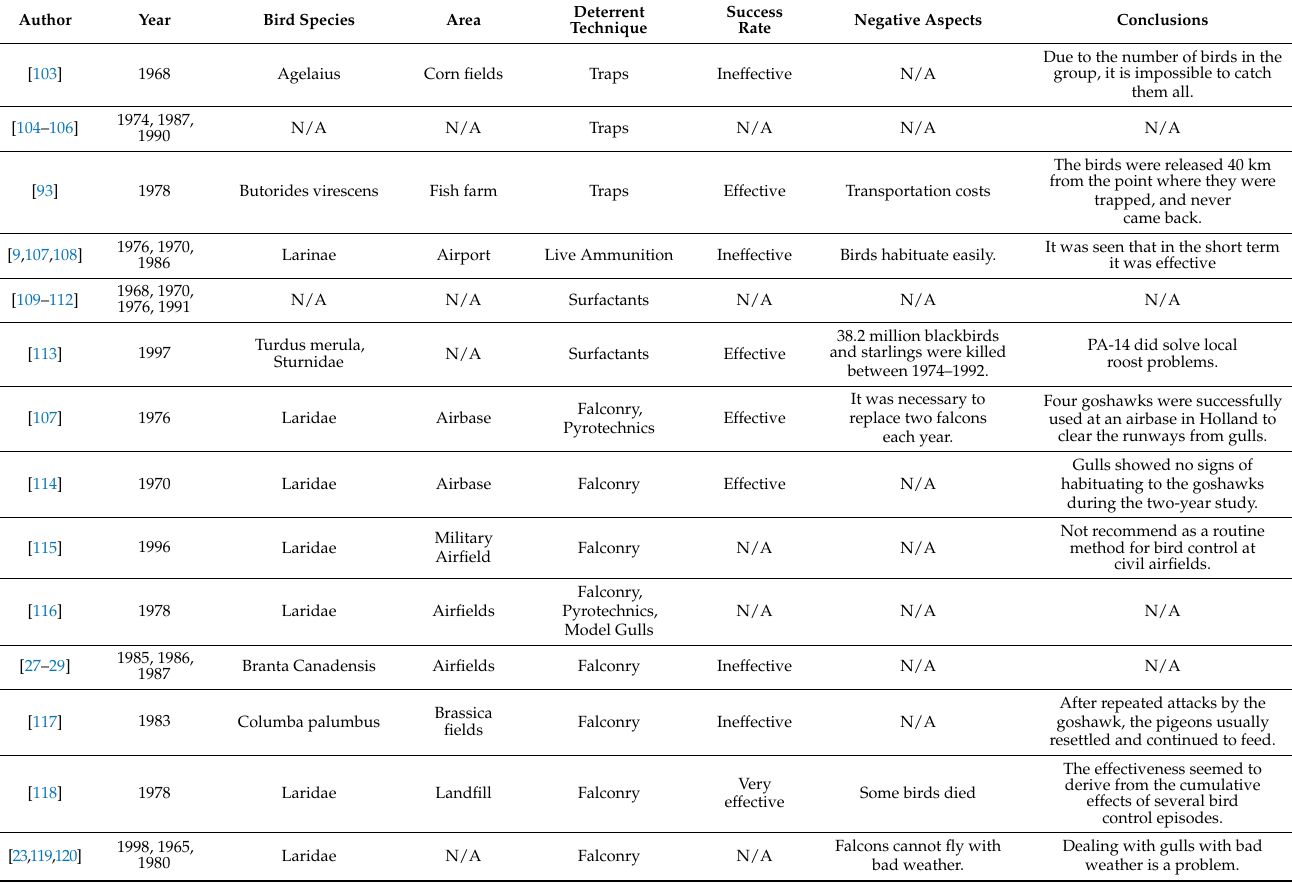
Table 6. Summary of the studies using removal